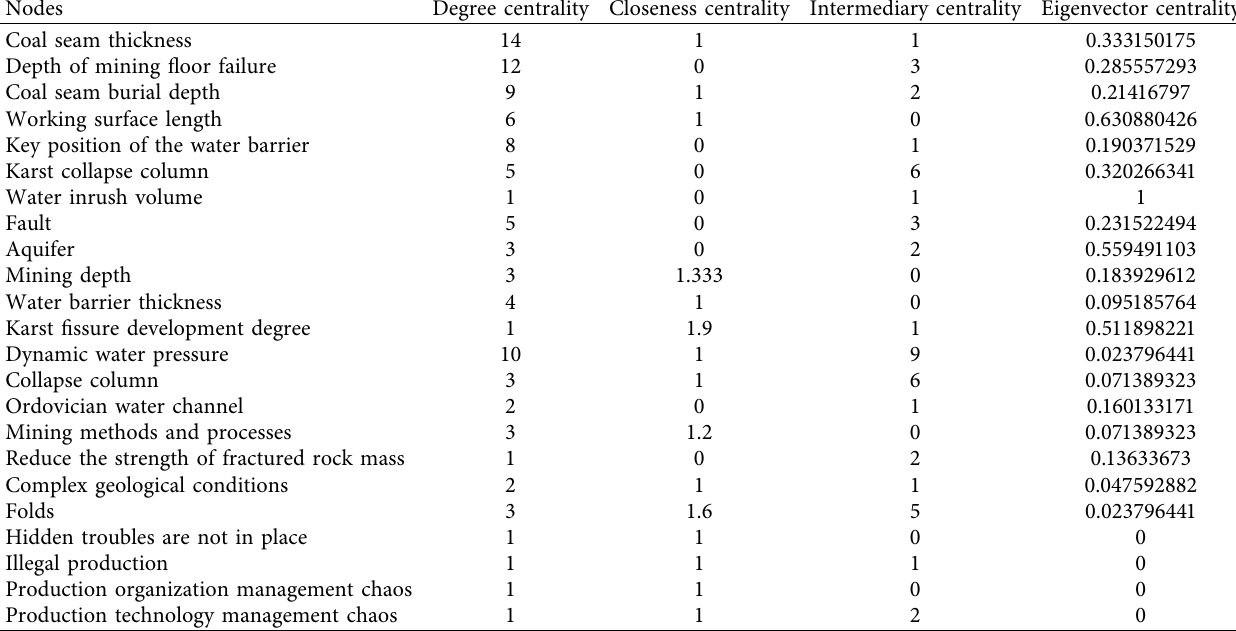
Table 1: The most important multiple